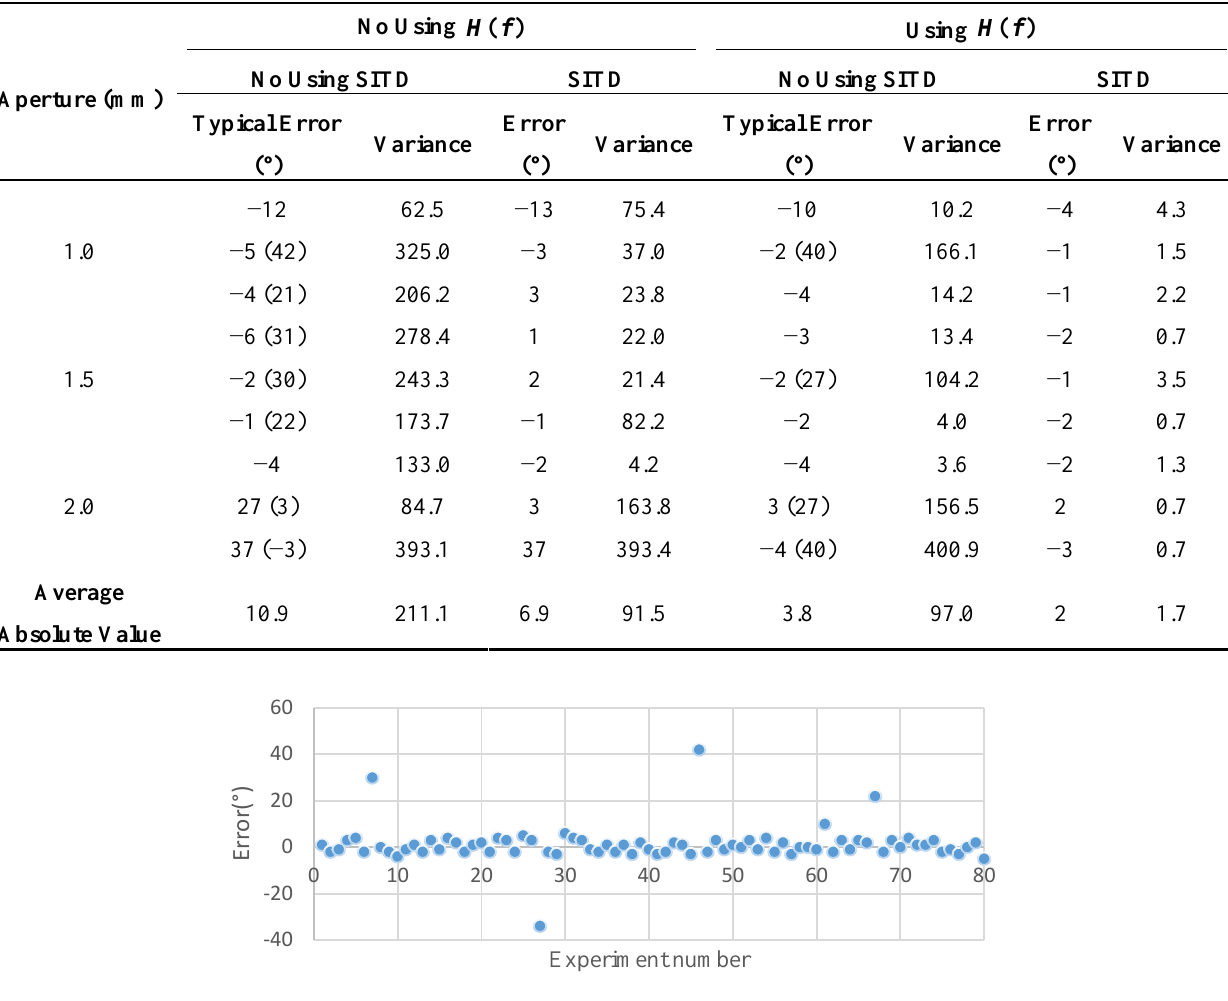
Table 1. The orientation results comparison.